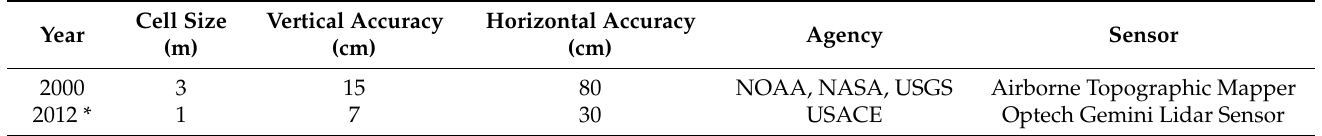
Table 1. Lidar data specifications (year, cell size, vertical and horizontal accuracy, agency, and sensor) for ASIS 2000 [35] and 2012 [36].